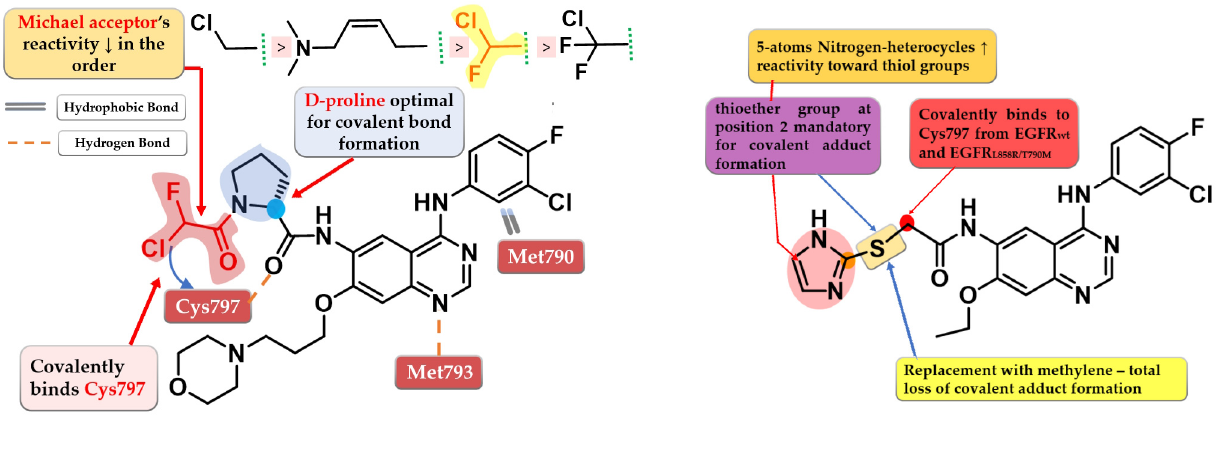
Figure 21. Structure–activity relationship and molecular docking of compound 30 covalently bonded in the human EGFR L858R/T790M kinase domain (PDB ID 5Y25), as reported by Shindo et al. [173]; structure–activity relationship of compound 31, as reported by Castelli et al. [174].